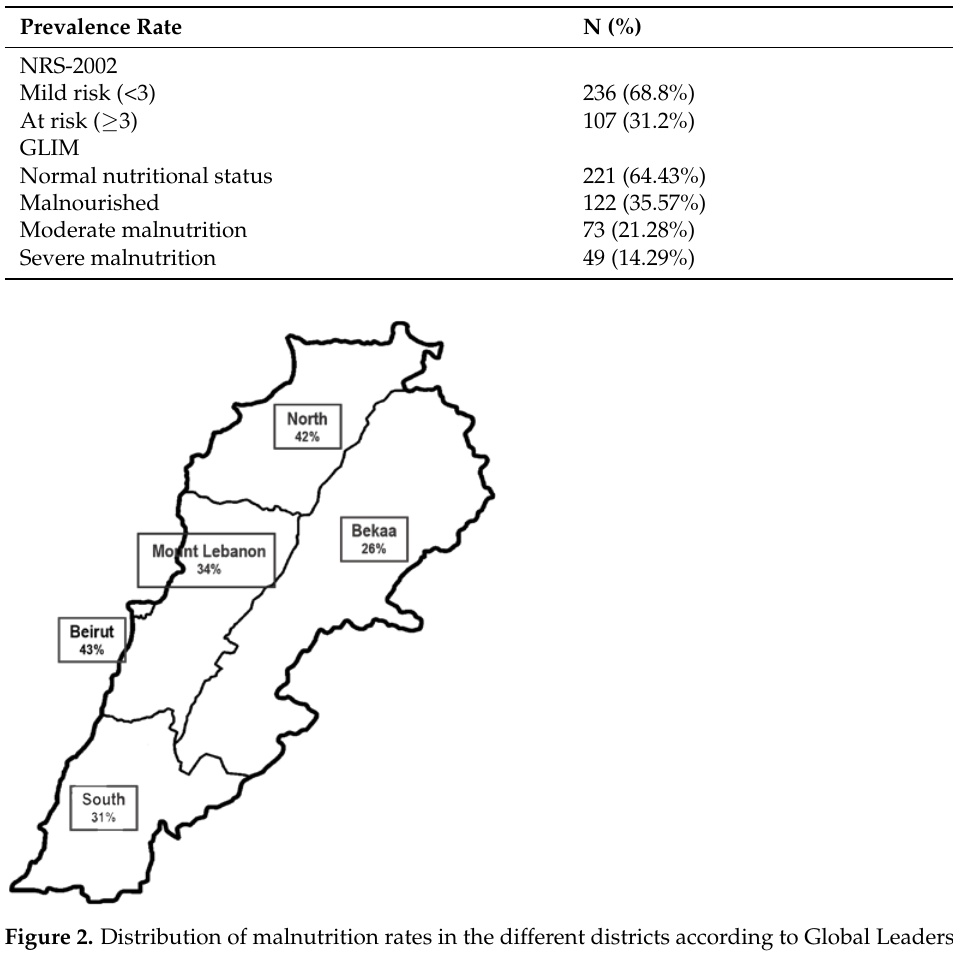
Table 3. The prevalence of malnutrition according to Nutrition Risk Screening (NRS-2002) and Global Leadership Initiative on Malnutrition (GLIM) (N = 343).